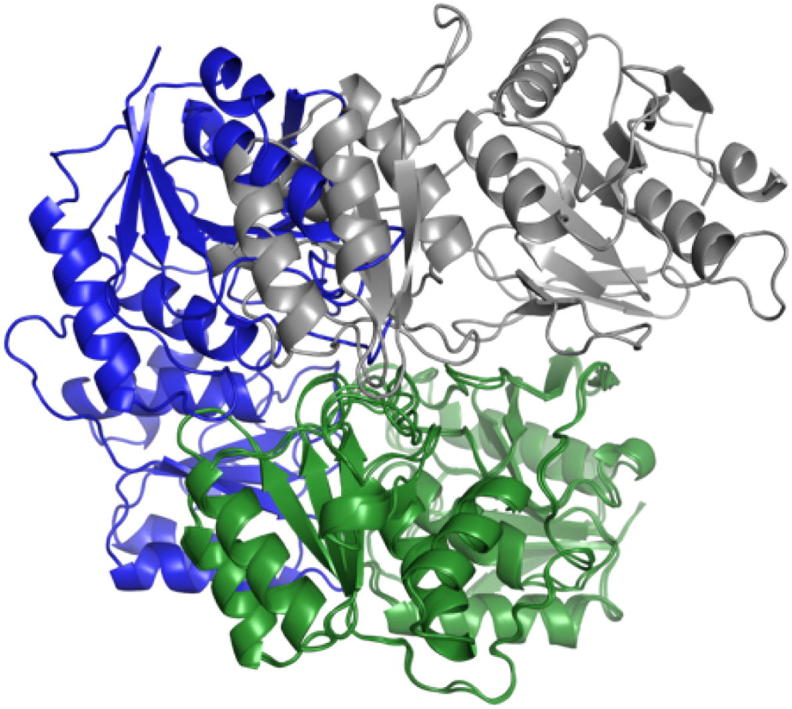
Superimposition on chain A (in green) of the third (in gray) and the best (in blue) dimer configurations in the first run. (For interpretation of the references to colour in this figure legend, the reader is referred to the web version of this article.)